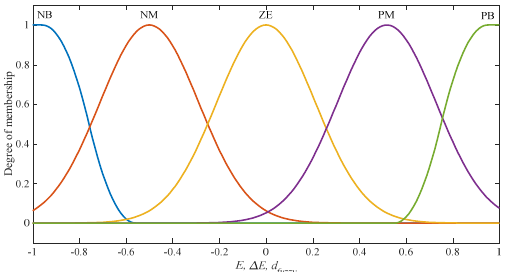
Table 2. The positive parameters r 1 , r 2 , and r 3 are the design parameters used to scale the inputs and outputs of the fuzzy system.